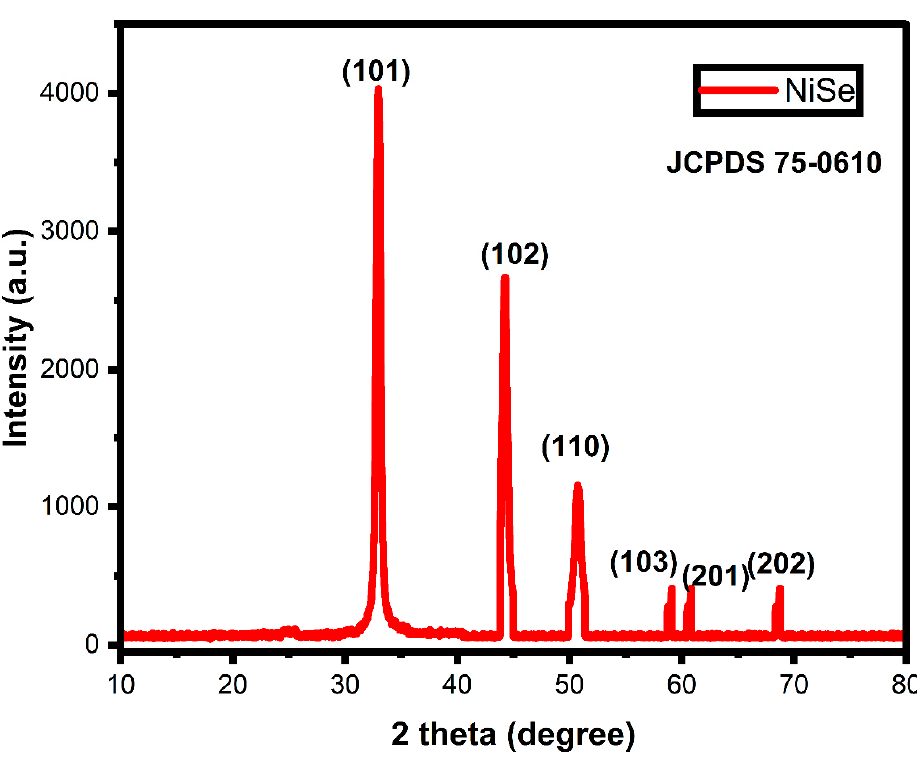
Figure 2. XRD pa tt ern of green synthesized NiSe NPs. Figure 2. XRD pattern of green synthesized NiSe NPs.